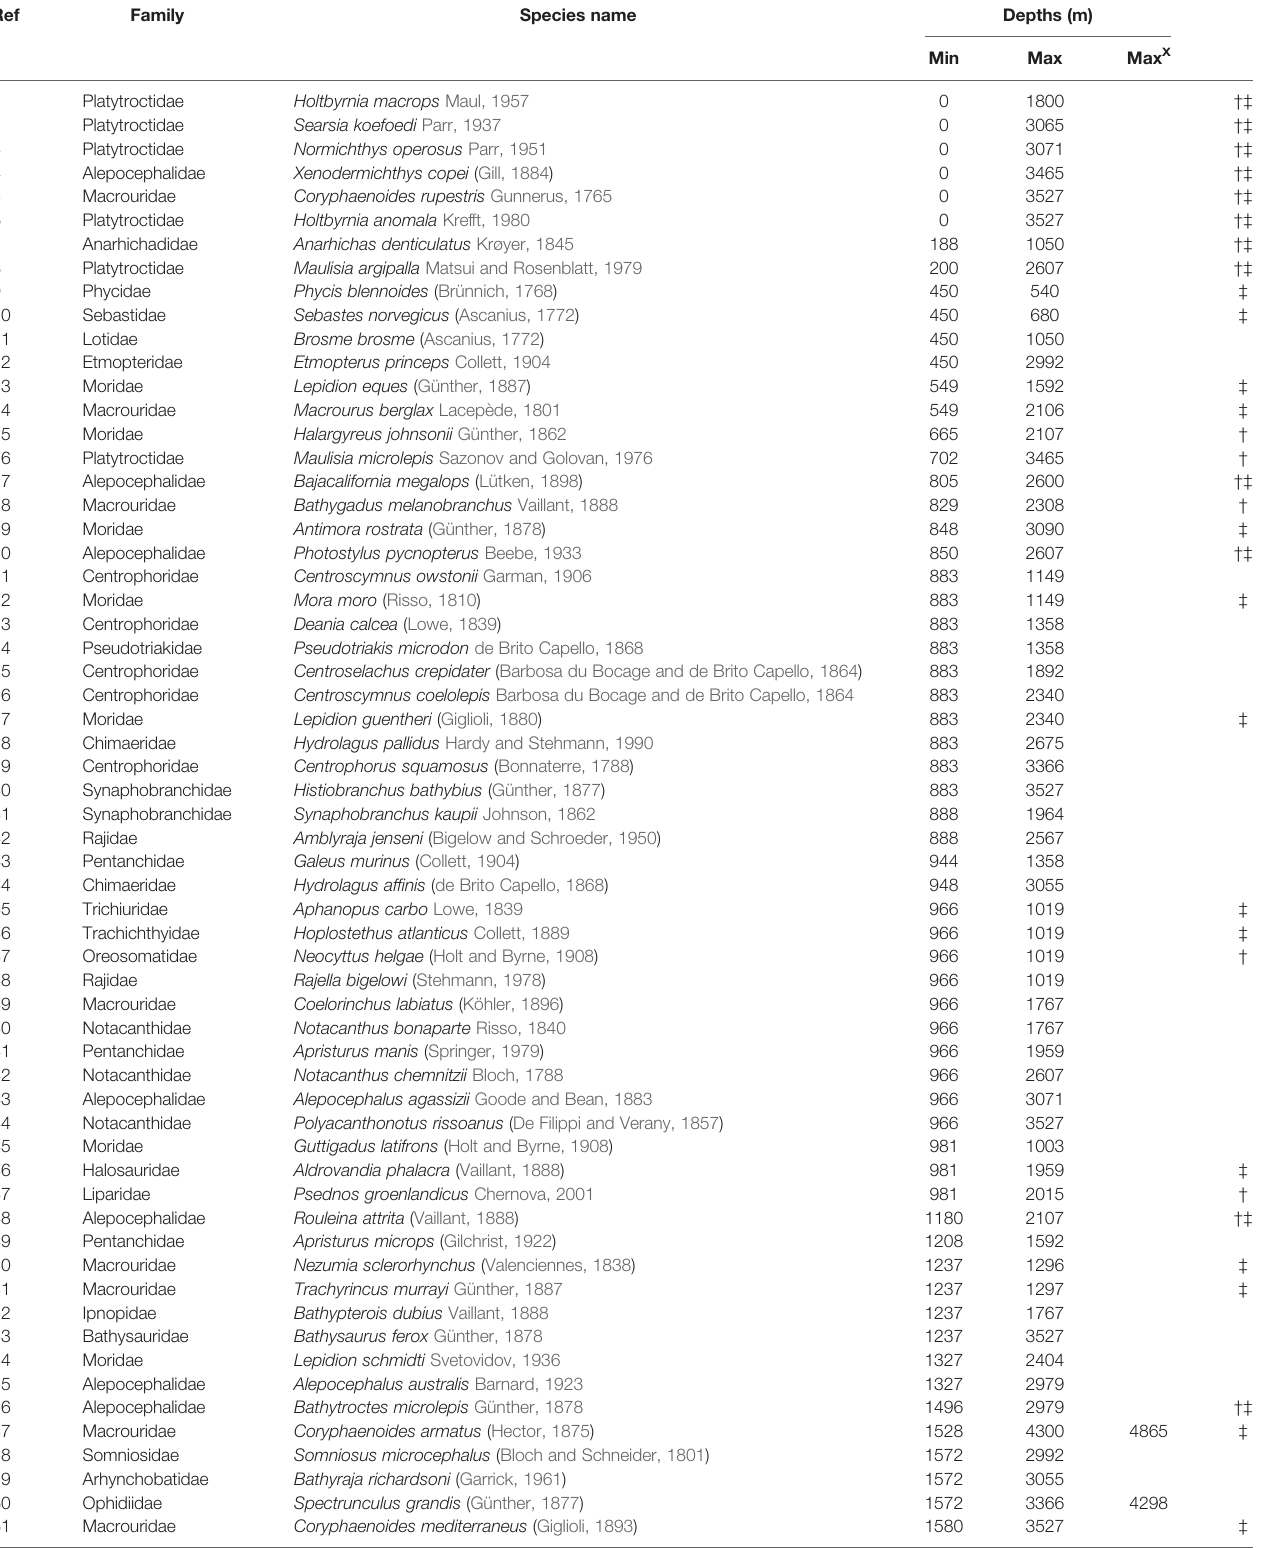
TABLE 3 | Demersal and Benthopelagic Fishes of the Mid Atlantic Ridge (41°-60°N) ranked in order of minimum depth of occurrence.